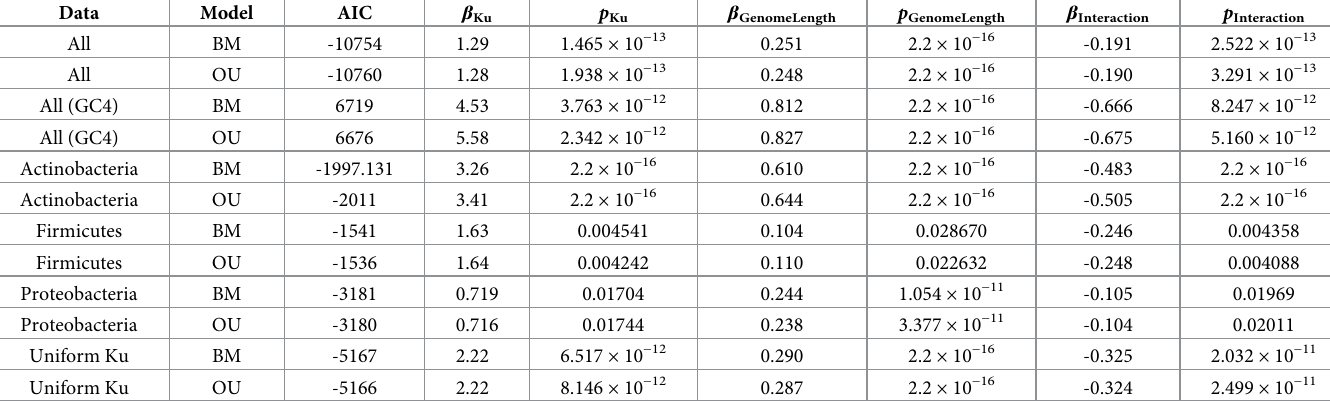
Table 1. Coefficients and p -values for all phylogenetic regressions performed. All tests significant after Benjamini-Hochberg correction ( α = 0.05). “Uniform Ku” refers to the dataset restricted to where Ku is always present/absent within each genus (see